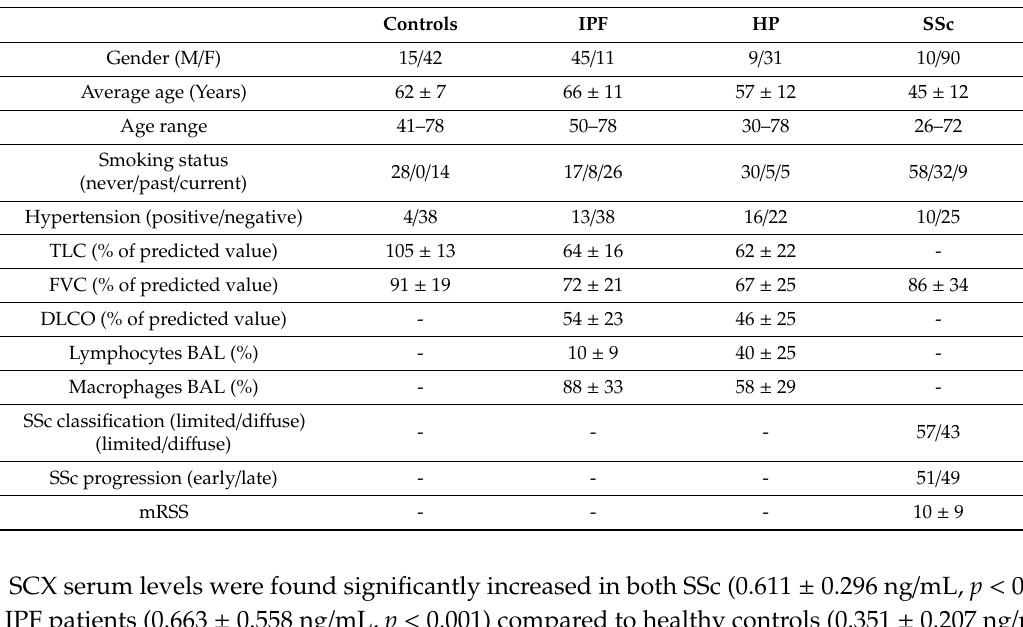
(Figure 4). SCX concentration in sera from HP patients (0.323 ± 0.323 ng/mL) did not differ from controls.